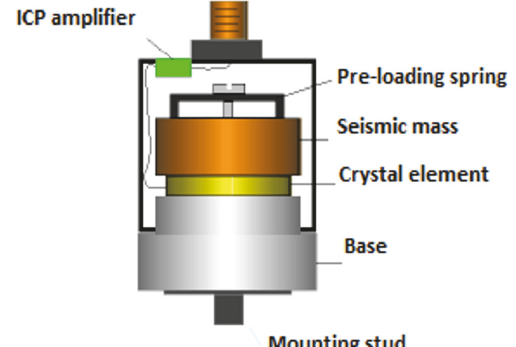
Figure 1: Construction of piezoelectric accelerometer.